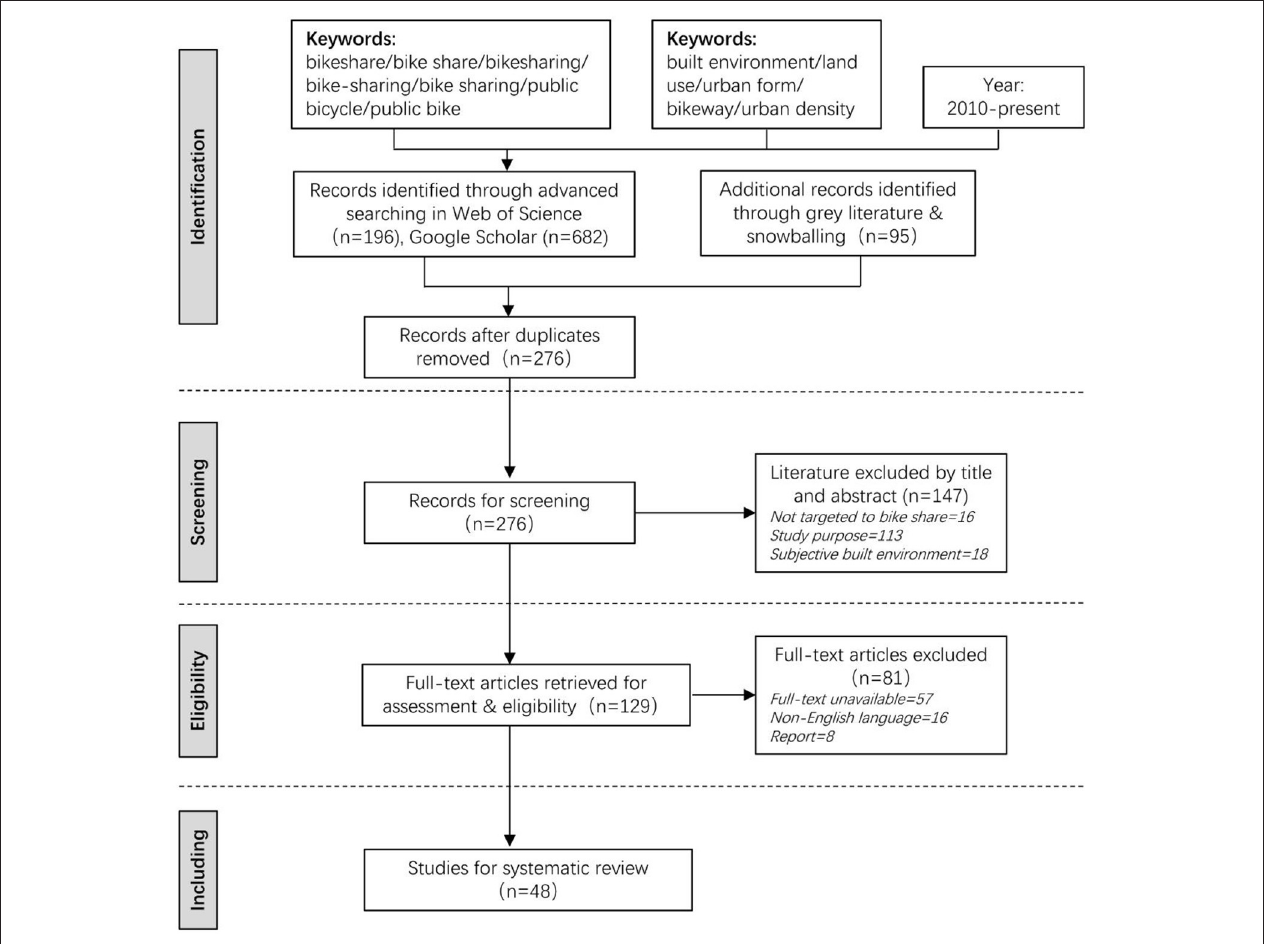
FIGURE 1 | Flow diagram of the literature search and selection process. identified and are discussed: mobility culture, bike share type (i.e., docked vs. dockless type), trip propose, usage pattern (i.e., arrival vs. departure), and day of